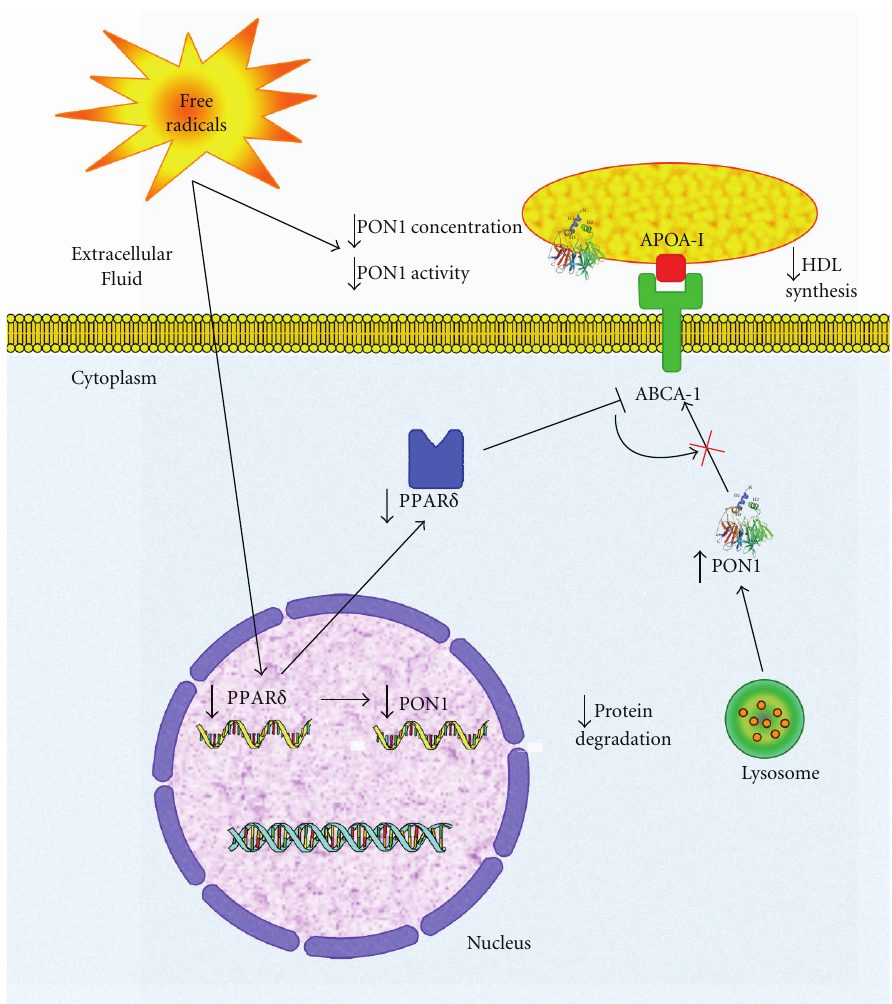
Figure 5: A hypothetical biochemical pathway that could explain the PON1 alterations observed in rats with experimental cirrhosis. Free- radical-induced liver impairment would result in a decrease in PPAR δ gene expression and, as a consequence, in PON1 gene expression. It would also induce an inhibition of ABCA1, a decrease in HDL synthesis, and, therefore, a decrease in serum PON1 concentration. Intrahepatic PON1 levels would be increased as a consequence of decreased protein degradation. This figure is reproduced from